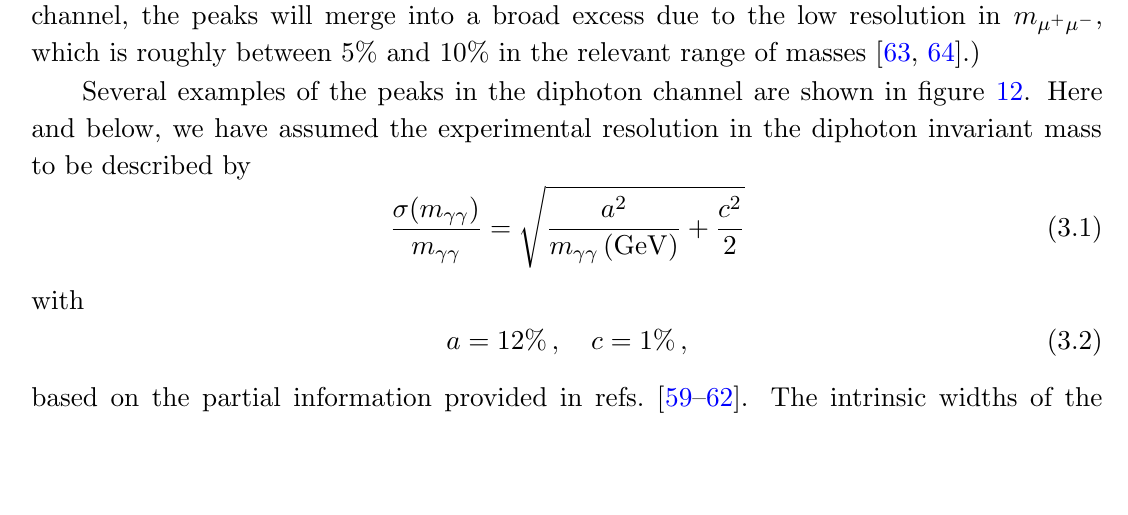
, (cid:22) + (cid:22) (cid:0)